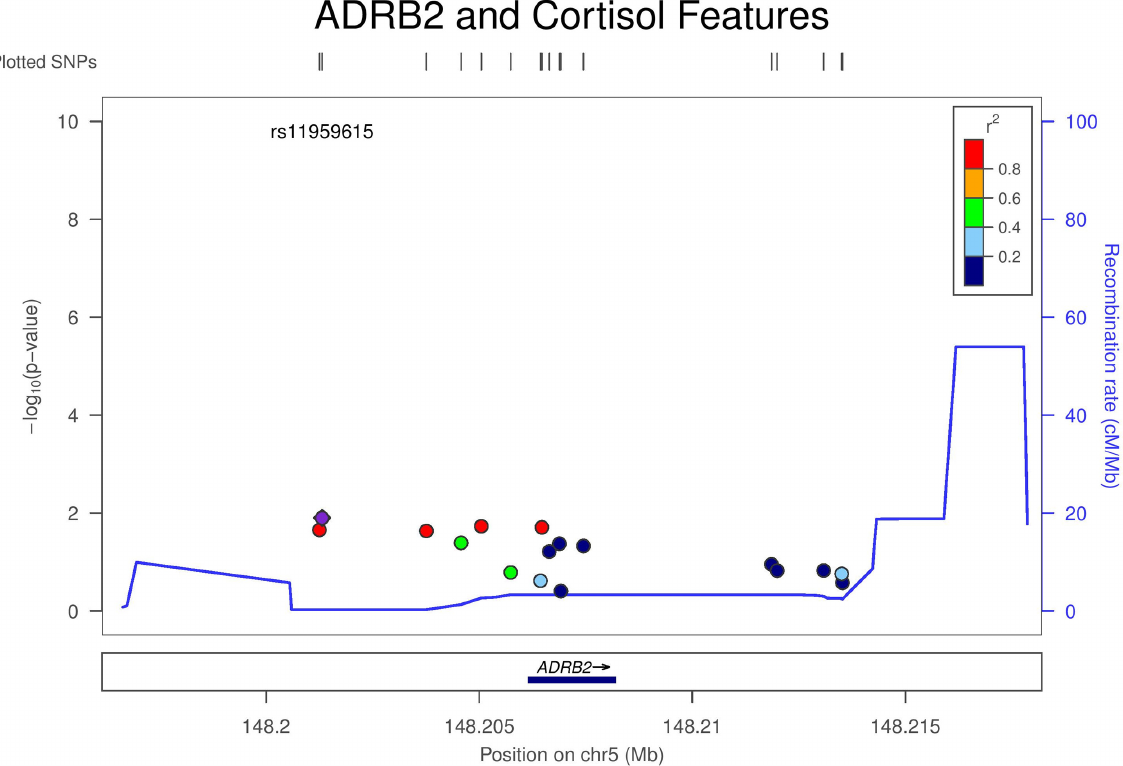
Fig 2. LocusZoom plot of the association between all SNPs in the ADRB2 gene region and cortisol features. Each SNP in the ADRB2 gene region was analyzed by MultiPhen (O ’ Reilly et al., 2012) stratified by ethnicity. Then the meta-analysis p-values were calculated using Fisher ’ s probability test and plotted using LocusZoom (Pruim et al., 2010). The linkage disequilibrium is based on the European Americans. This is labeled as Method 2 in the